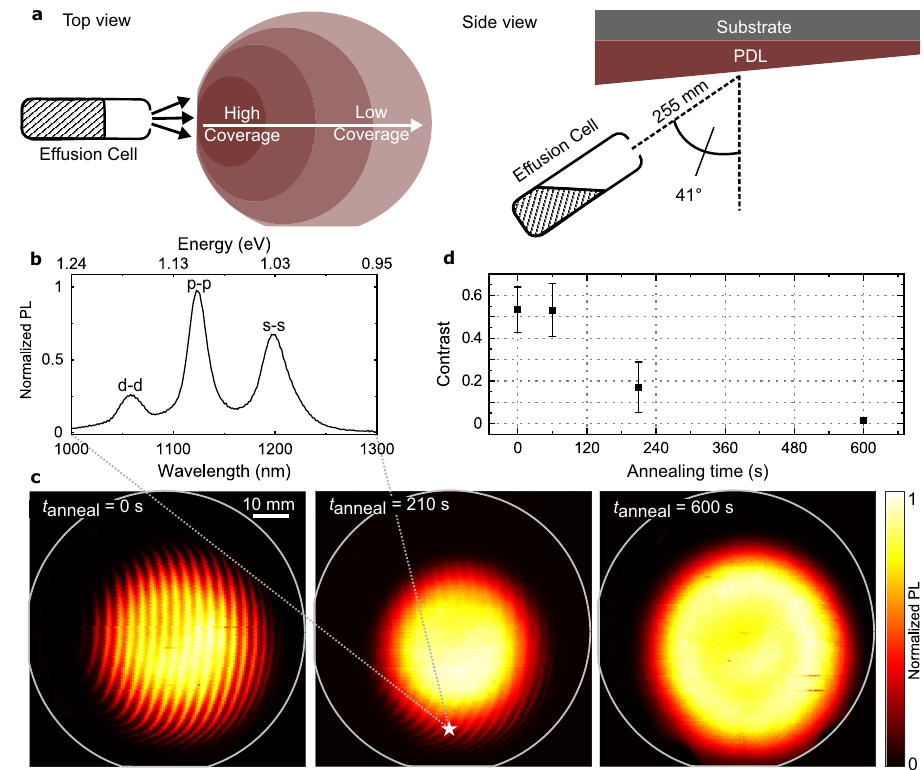
Fig. 1 Effusion cell geometry and QD density modulation. a Schematic representation of the gradient of material coverage on the substrate in top view (left) and geometrical con fi guration of the gallium effusion cell inside the MBE growth chamber viewed from the side (right). b Ensemble photoluminescence (PL) spectrum at 100K with a laser spot size of ~100 µ m from a 210s annealed sample (white star). The different peaks correspond to the different dipole and parity allowed interband transitions between orbital states. c False color PL maps recorded from 3 ″ wafers with a nominally 15nm thick GaAs pattern de fi ning layer (PDL). The QD PL intensity is spectrally integrated over the region between 1000 and 1300nm. The wafers were annealed before the QD growth for 0s, 210s, and 600s, respectively. d Michelson contrast at medium densities versus the annealing time. Error bars represent the standard